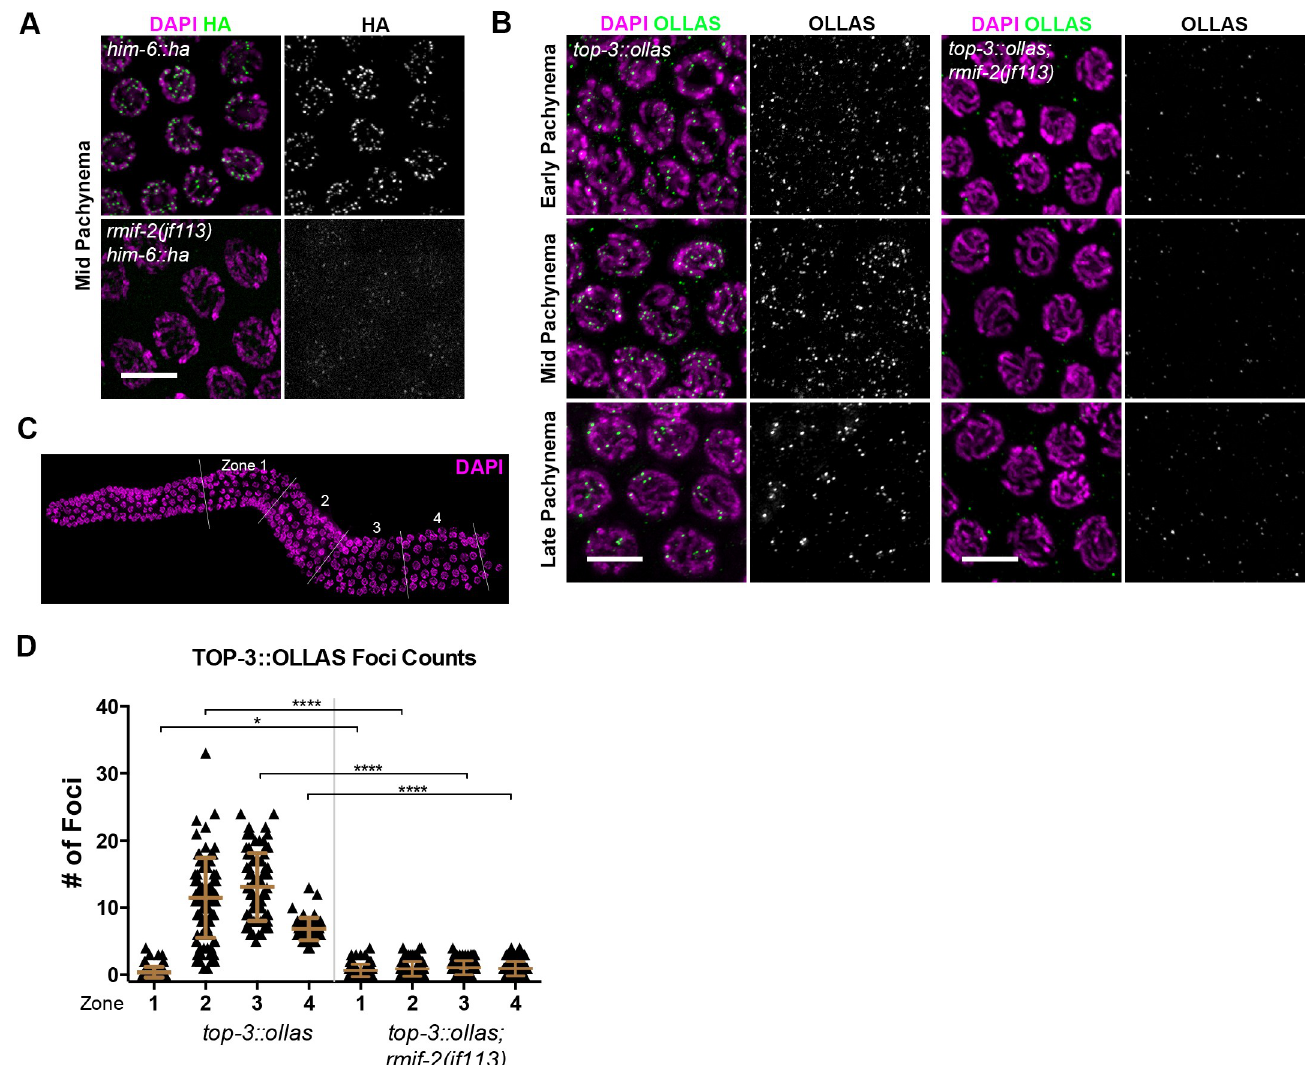
Fig 4. Localization of HIM-6 and TOP-3 in the rmif-2 mutant. (A) Representative him-6 :: ha and rmif-2(jf113) him-6 :: ha nuclei in mid pachynema stained with DAPI (in magenta) and HA (in green). HIM-6 localizes to bright foci throughout pachynema in him-6 :: ha . In the rmif-2 mutant, HIM-6 is detected in small, faint foci throughout pachynema. Scale bar: 5 μ m. (B) Representative images of nuclei throughout pachynema stained with DAPI (in magenta) and OLLAS (in green). TOP-3::OLLAS localizes to distinct foci throughout early, mid, and late pachynema. In the rmif-2 mutant, TOP-3 fails to localize properly, and only a few cytoplasmic and nuclear foci can be observed. Scale bars: 5 μ m. (C) For the quantification of TOP-3::OLLAS foci three gonads per genotype were each divided into four equal zones from the transition zone (beginning of meiosis) until late pachynema. (D) Quantification of TOP-3 foci in top-3 :: ollas and top-3 :: ollas; rmif-2 backgrounds, throughout the C . elegans gonad. The mean number of TOP-3 foci in each zone was WT: zone 1: 0.4 ( ± 0.8 SD), n = 97 nuclei; zone 2: 11.5 ( ± 6 SD), n = 89; zone 3: 13.1 ( ± 5 SD), n = 79; and zone 4: 6.8 ( ± 1.6 SD), n = 57; rmif-2 : zone 1: 0.6 ( ± 0.9 SD), n = 103 nuclei; zone 2: 0.9 ( ± 1.0 SD), n = 109; zone 3: 1.0 ( ± 1.0 SD), n = 94; zone 4: 0.7 ( ± 0.98 SD), n = 57.